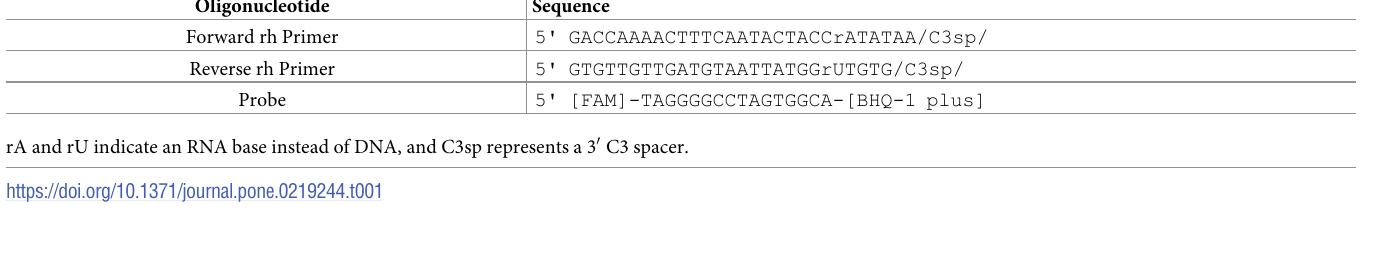
Table 1. Forward and reverse primers and probe sequences used in RNase-H dependent qPCR assay for detecting N . fasciata and N . sipedon .